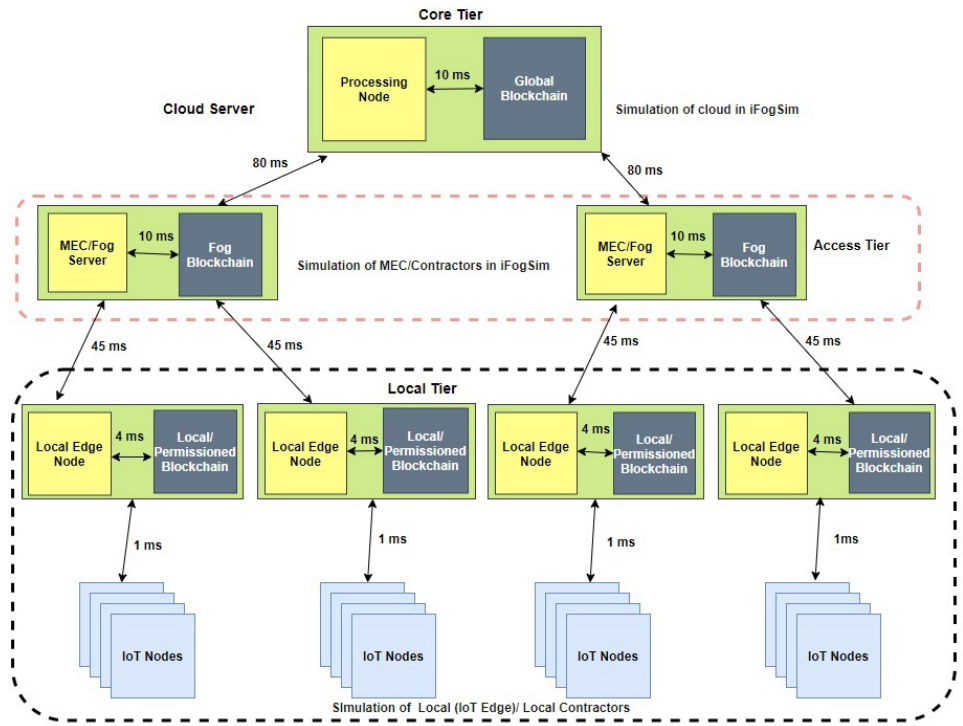
Figure 3. High-level design of the Health-BlockEdge framework in iFogSim. MEC, Multi-access Edge